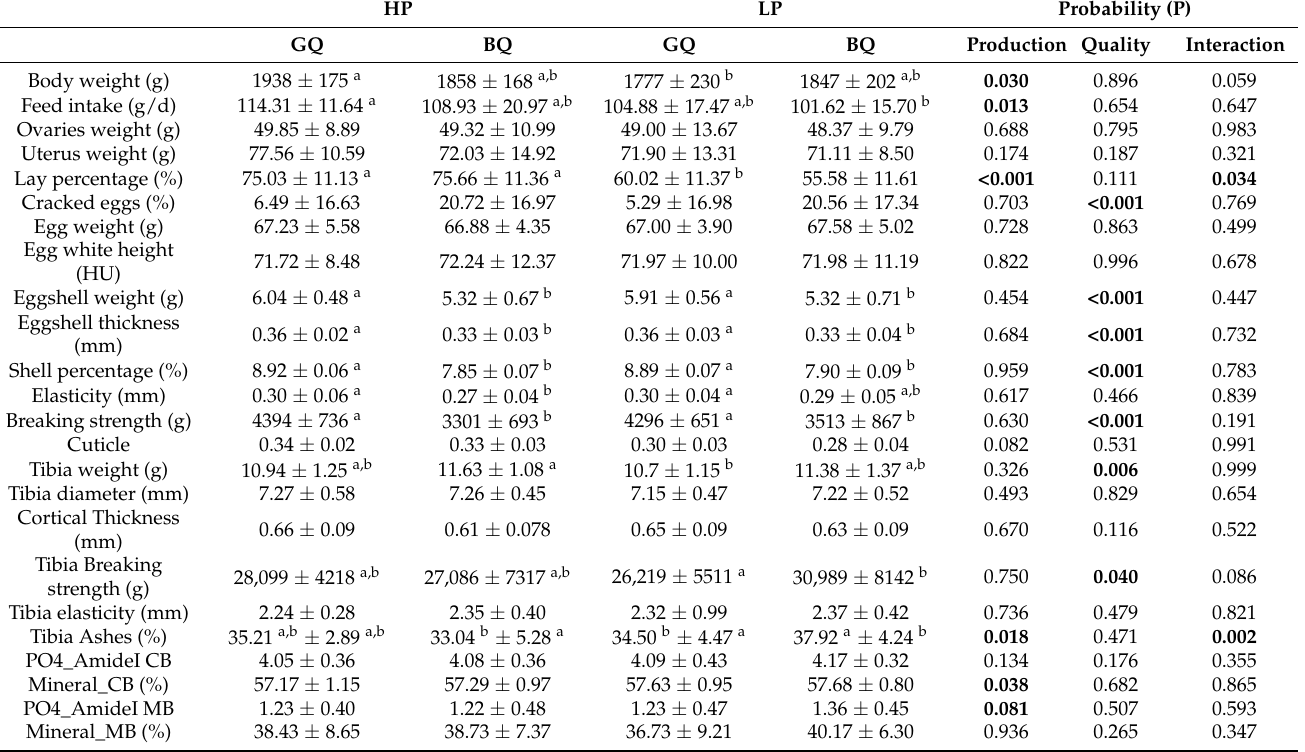
Table 2. Hen-, egg-, and tibia-related parameters. HP: High production; LP: Low Production; GQ: Good Quality; BQ: Bad Quality; HU: Haugh unit; CB: Cortical Bone; MB: Medullary Bone. Significant different are highlighted in bold. Differences between groups (Tukey ´ s tests) indicated by a,